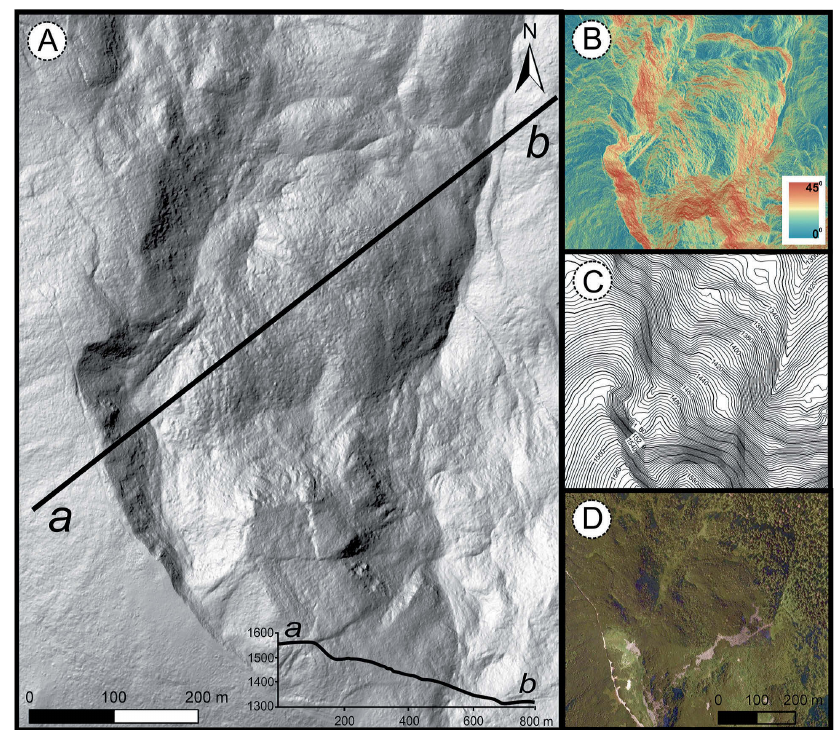
Fig. 6. Test area No 5. A – LiDAR image (a–b – topographic profile and its location), B – the map of slope reductions generat- ed from LiDAR (range of slope reductions is given), C – contour-line map, D – orthophotomap. Maps B–D at the same scale, Map A at larger scale